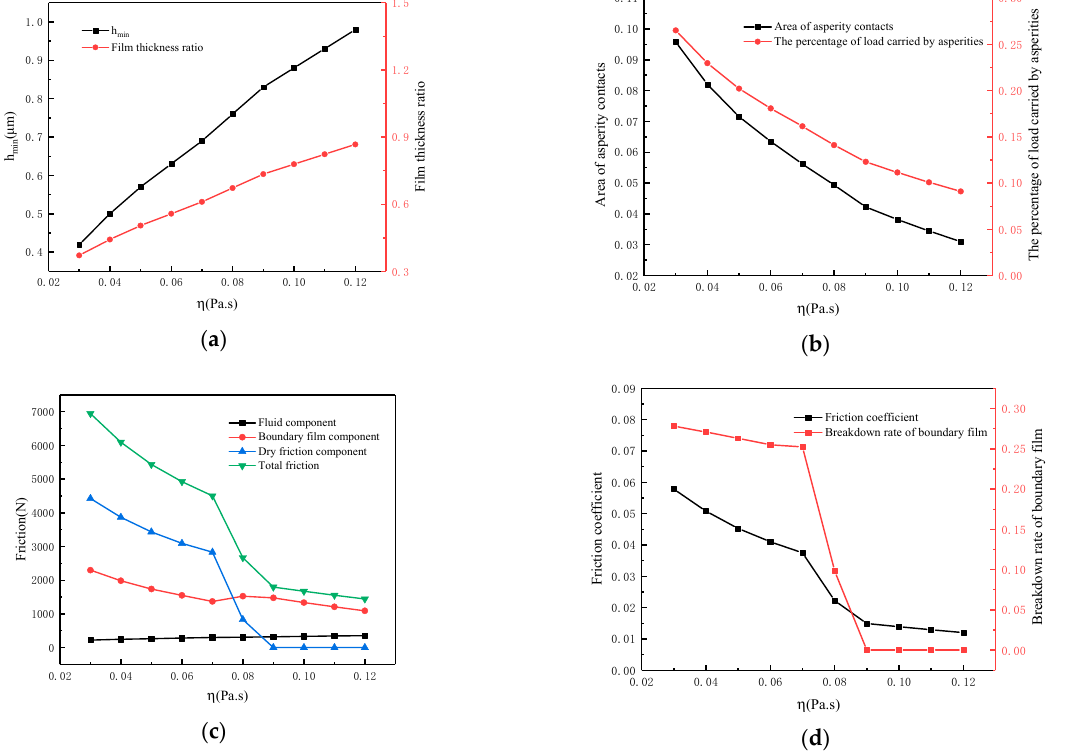
Figure 15. Influence of viscosity on lubrication performance. ( a ) Calculated film thickness; ( b ) Calculated asperity contacts; ( c ) Calculated friction components; ( d ) Calculated friction coefficient.